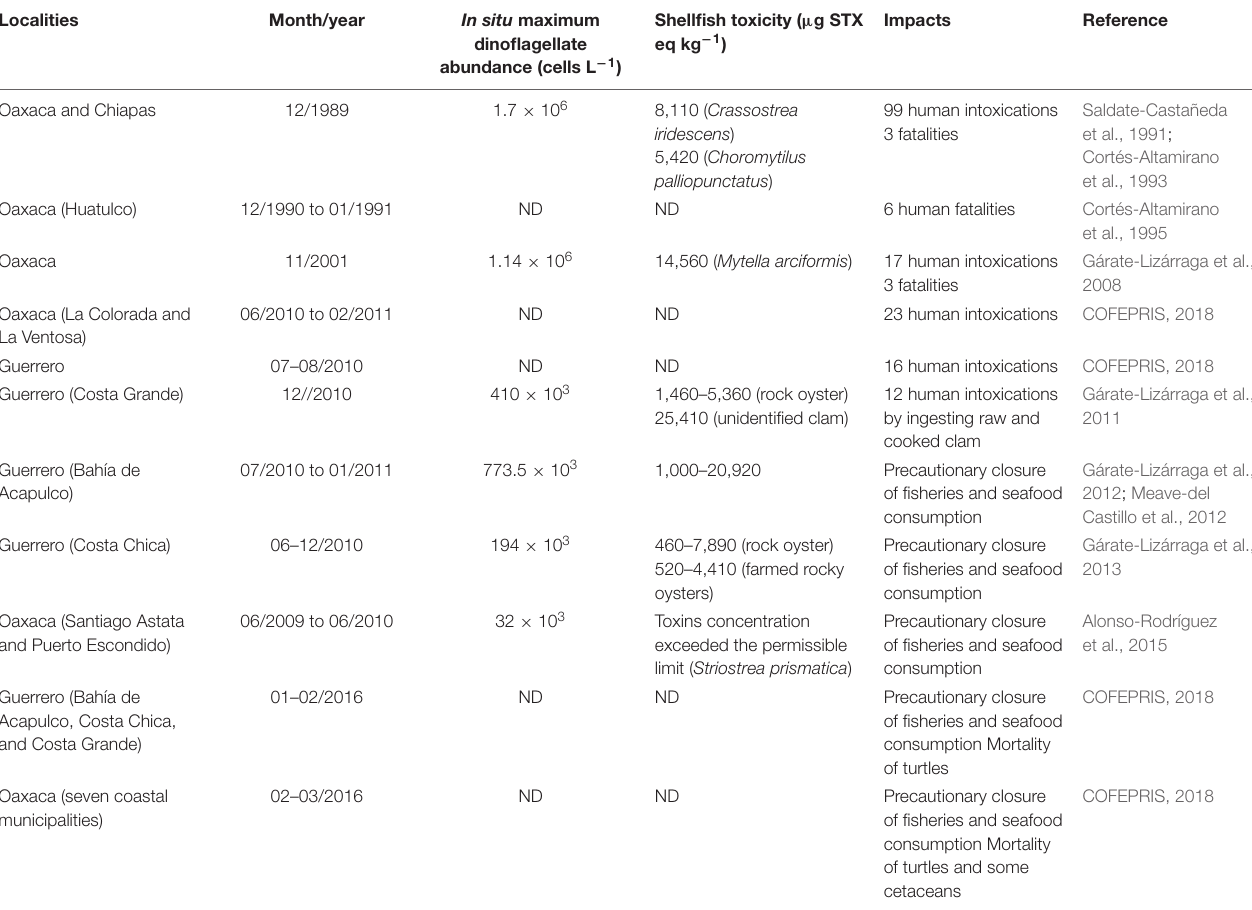
TABLE 1 | Pyrodinium bahamense blooms associated with human PSP outbreaks and wildlife mortalities in Mexican Pacific.